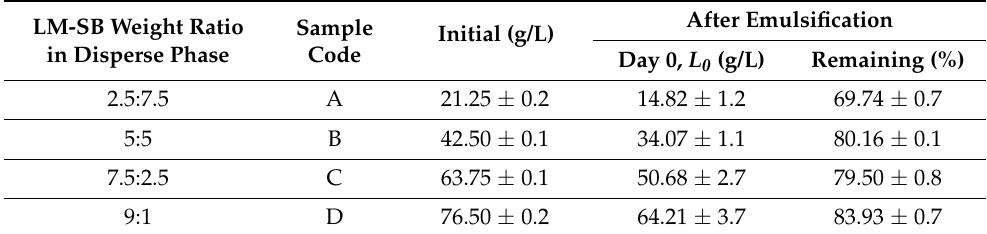
Table 1. Remaining of D-limonene in the emulsions after